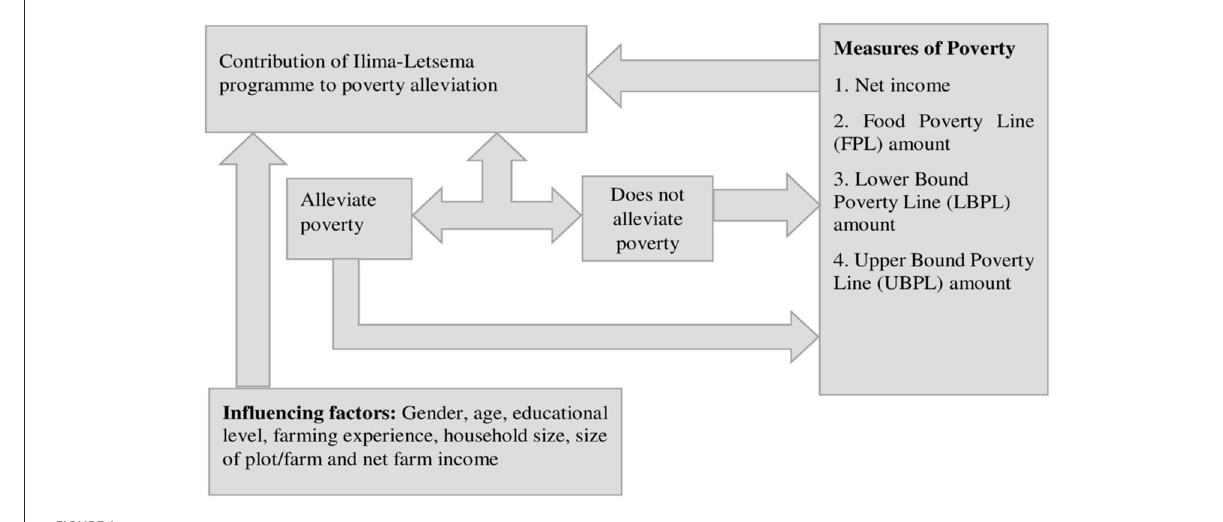
FIGURE1 Theoretical framework of the